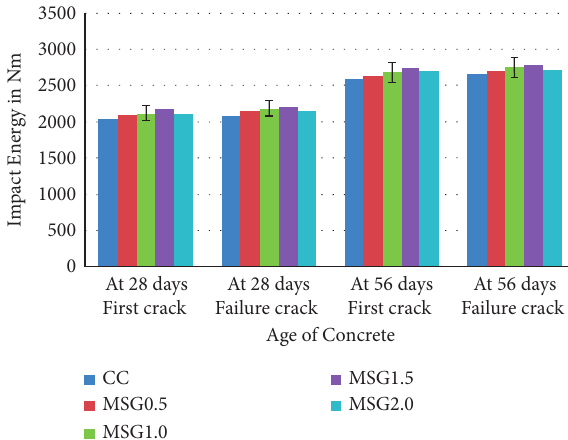
Figure 9: Impact energy of various